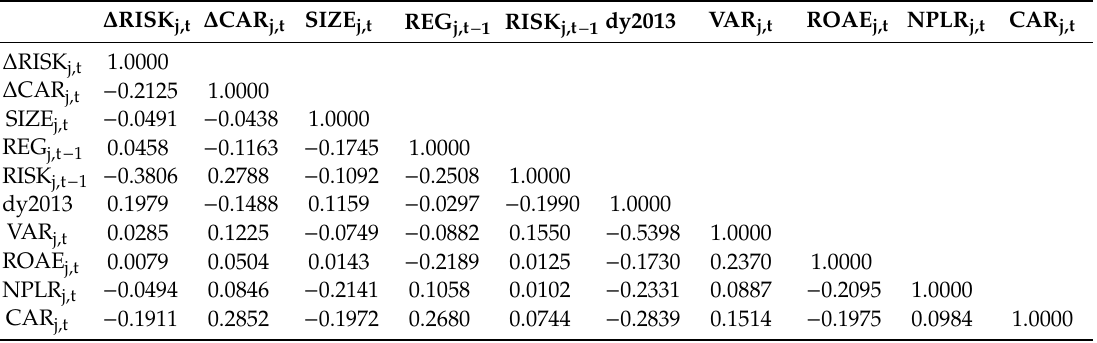
Table 3. Correlations among